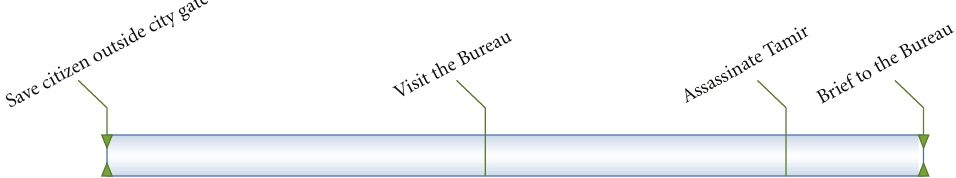
Figure 3: Damascus operational timeline: four mandatory events with fixed ordering.